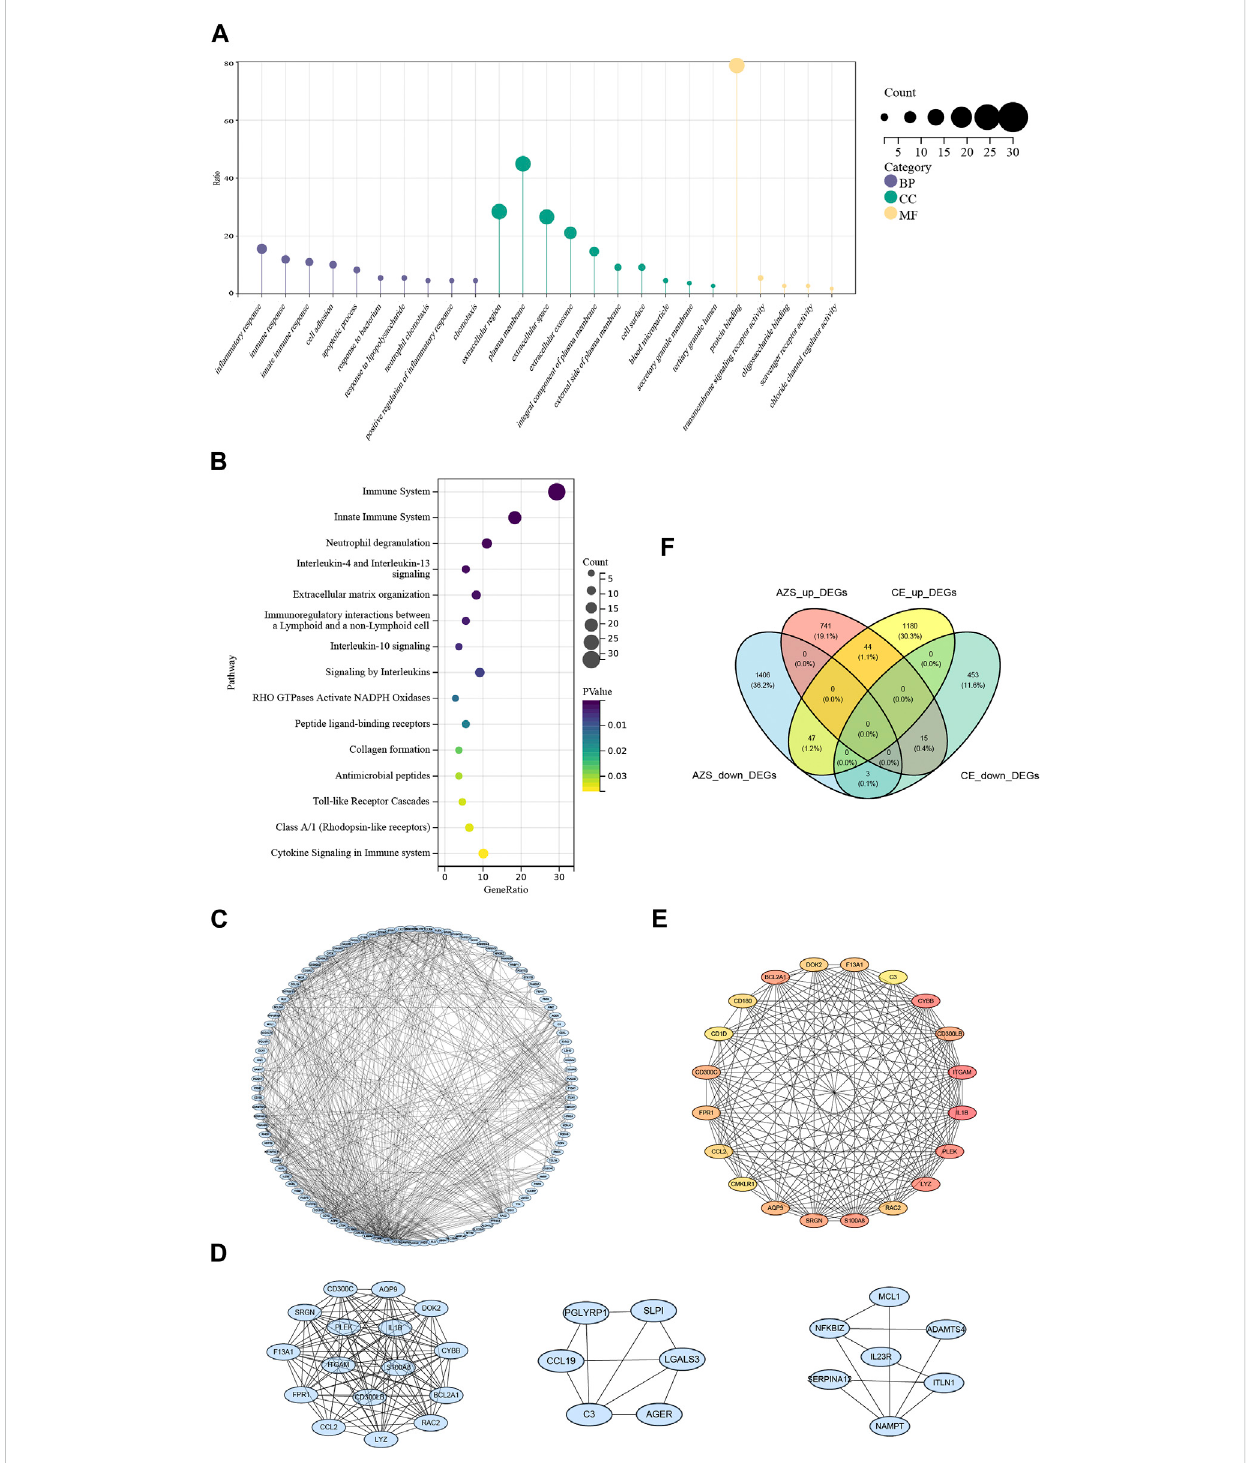
Functional enrichment results and protein-protein interaction network of intersected DEGs. (A) GO cluster enrichment in BP, CC, and MF. (B) Pathway enrichment for intersected DEGs. (C) The protein-protein interaction (PPI) network for intersected DEGs. (D) Top three key modules screened fromPPInetwork. (E) Thetop20DEGsinteractionnetworkscreenedfromthePPInetworkbasedonMCODE. (F) Venndiagramfromco-DEGsoftheAZS DEGs and CE DEGs. Co-DEGs denote the intersected DEGs with the same expression trend (upregulation and downregulation) in the AZS dataset and CE dataset. AZS: asthenozoospermia; CE: chronic epididymitis; DEGs: differently expressed genes; co-DEGs: co-expressed differentially expressed genes; GO: Gene Ontology; BP: biological process; CC: cellular component; MF: molecular function; PPI: protein-protein